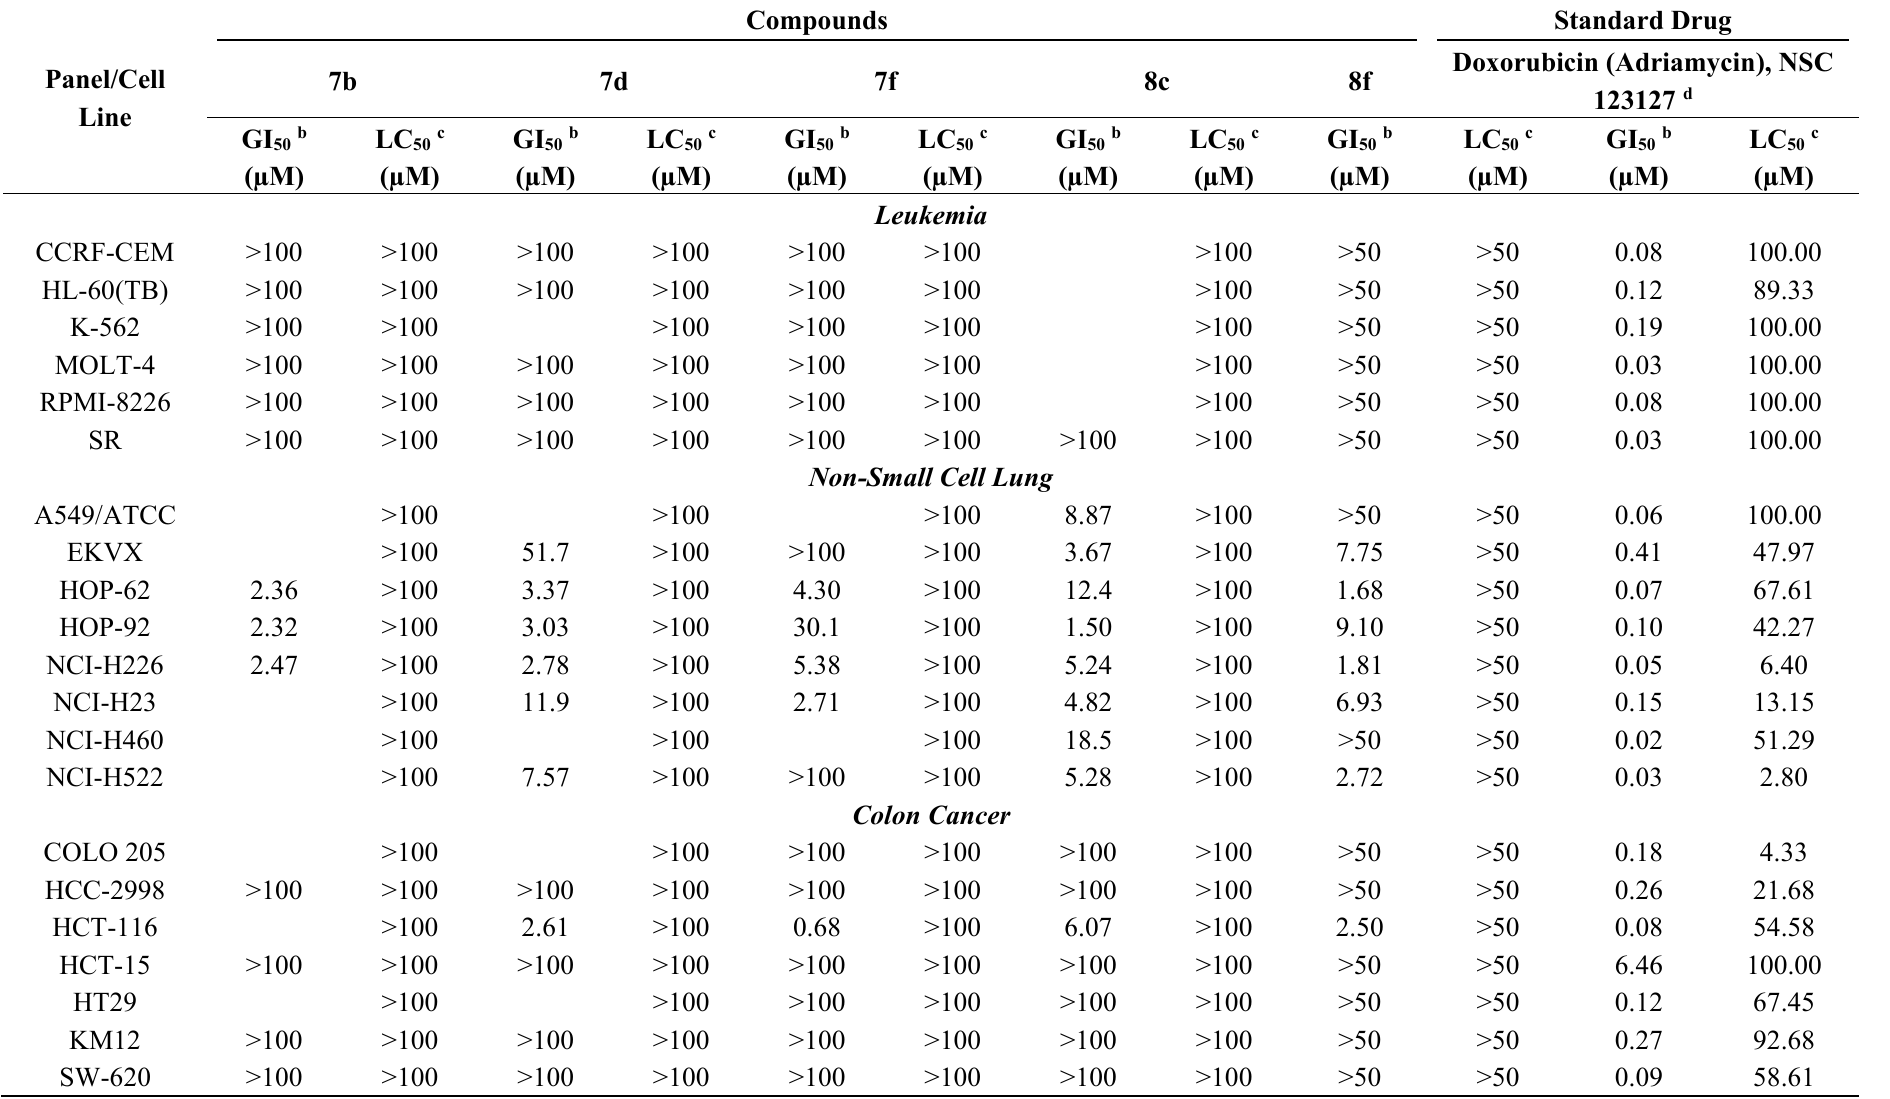
Table 1. In vitro testing expressed as growth inhibition of cancer cell lines for compounds 7b , d , f and 8c , f and the standard drug adriamycin a .